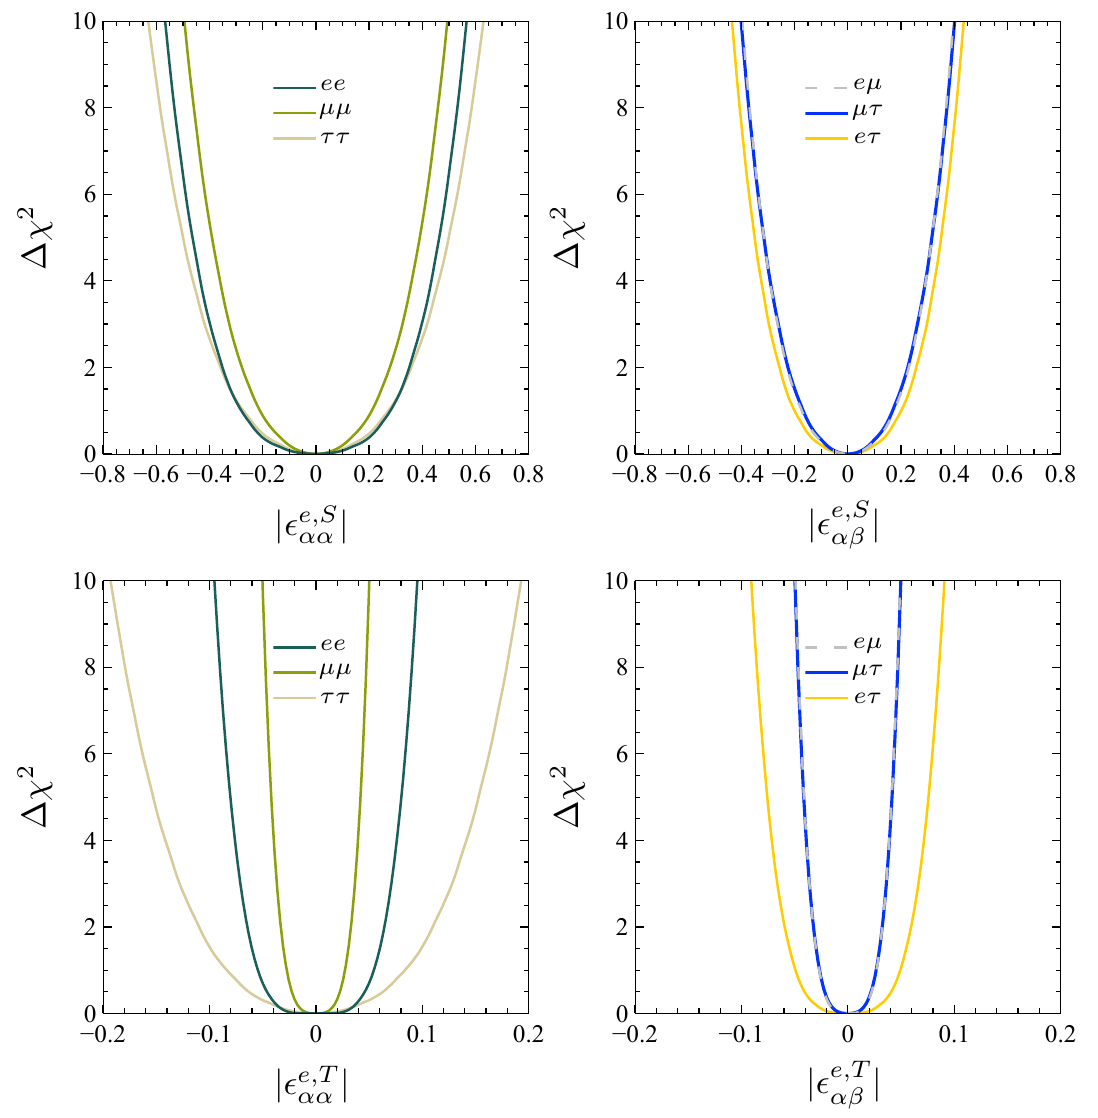
Figure 2 . Global constraints on the neutrino-electron interaction parameters from different exper- iments. The upper (lower) panels correspond to the scalar (tensor) parameters. In the left (right) panels we present limits for the flavor-diagonal (changing)